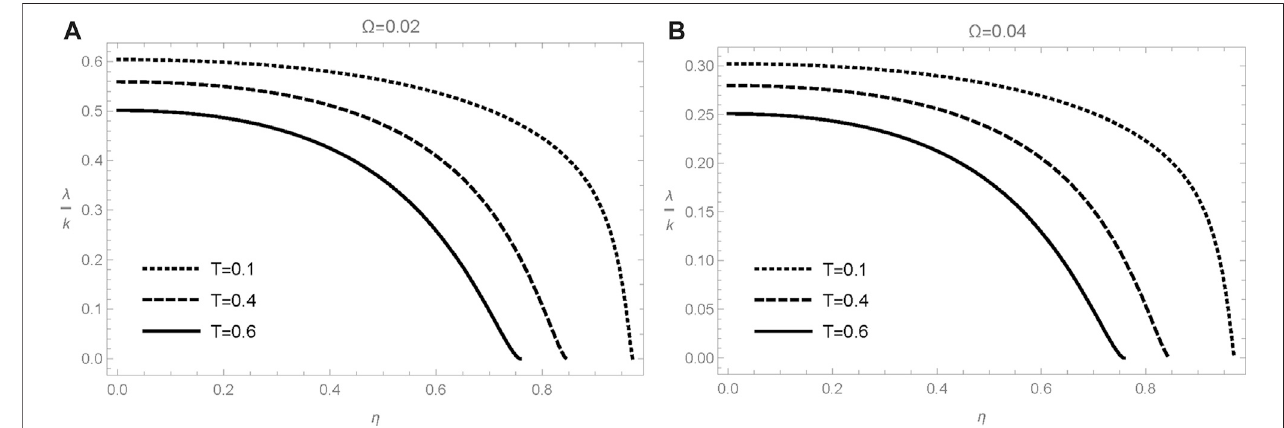
FIGURE 4 | First order growth rate of the instability with arbitrary k (i.e., λ / k ) is plotted across the quantized magnetic fi eld parameter η for L (cid:4) (cid:1)